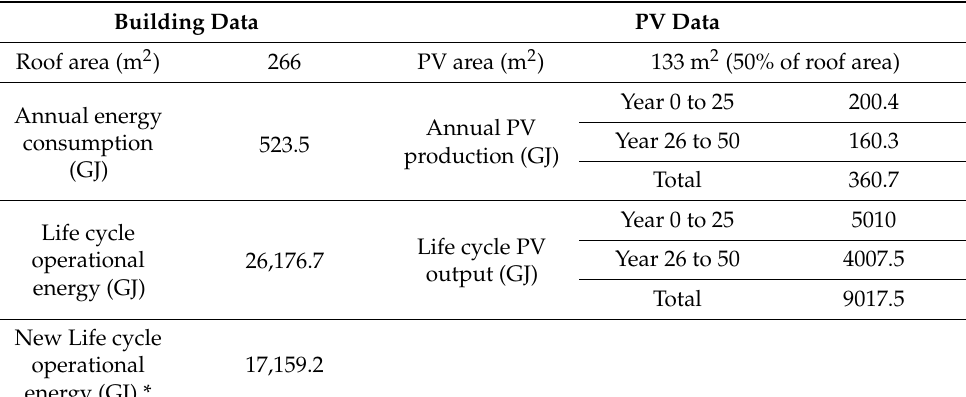
Table 3. Impact of PV panel adoption on Life cycle operational energy.